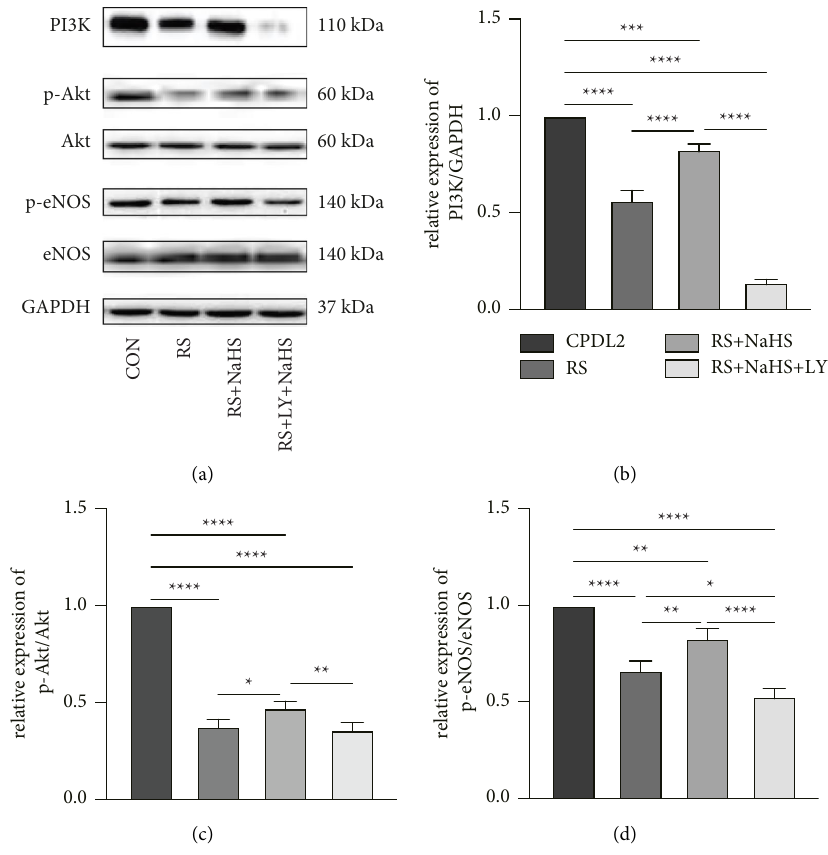
Figure 7: NaHS activated PI3K/Akt/eNOS signaling to alleviate replicative senescence of HUVECs. (a) Western blot analysis and statistics of p-PI3K (b), p-Akt (c), and p-eNOS (d) ∗ P < 0 . 05, ∗∗ P < 0 . 01 as examined by LSD-t test after ANOVA. CON: Control group, HUVECs at CPDL2; RS: replicative Senescence group, HUVECs at CPDL16; RS +NaHS: HUVECs at CPDL16 and exposed to 200 μ mol/L NaHS for 24hours. RS +NaHS+LY:HUVECs at CPDL16 and exposed to 10 μ mol/L LY294002 prior to treatment of 200 μ mol/L NaHS for 24 hours.